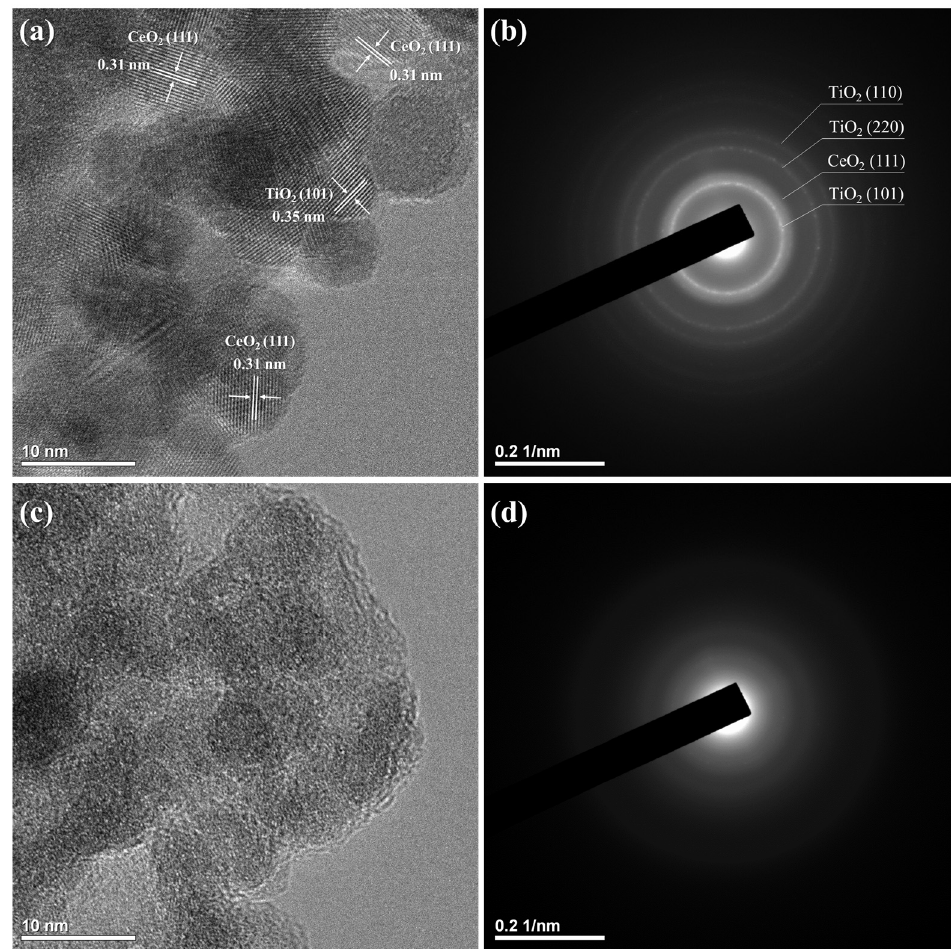
Figure 2. TEM images and SAED patterns of ( a , b ) CT and ( c , d ) CT_H 2 O